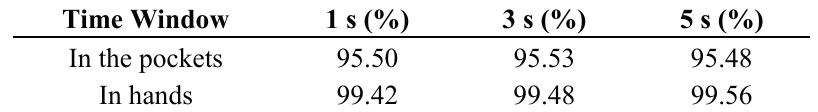
Table 6. Floor-positioning results under different carrying modes and time windows.